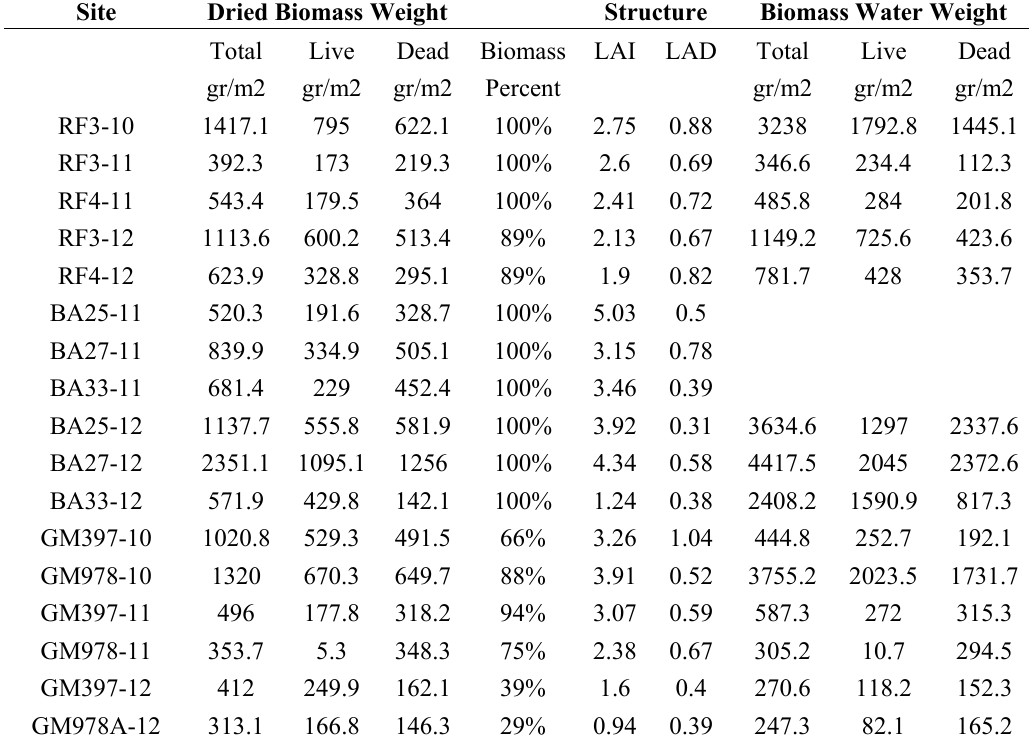
Table 1. Field Measured and Calculated Biophysical Variables. Site labels include the site name and year collected (RF = Rockefeller Refuge, BA = Barataria Bay, GM = Golden Meadow). All entries were adjusted for the water level recorded at the time of UAVSAR collection. The Biomass Percent refers to the magnitude of that adjustment. Note: There are two biomass weights, the dry weights and water